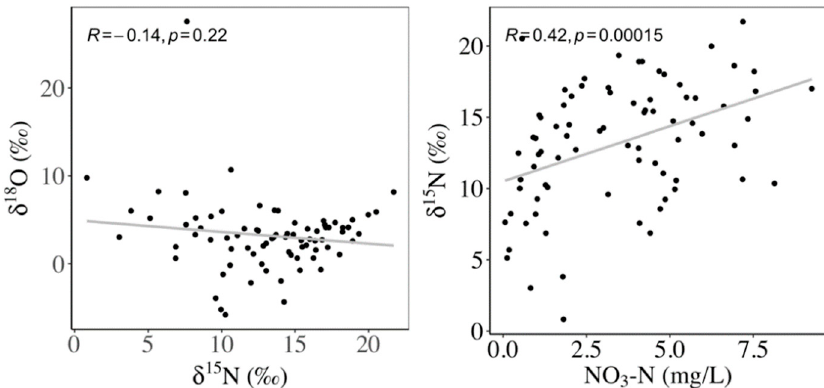
Figure 7. δ 15 N-NO 3 versus δ 18 O-NO 3 and NO 3 − -N in the Yuntaishan River. In the Yuntaishan River basin, the manure and sewage was the dominant source of NO 3 − -N (67%), which was higher than in other agricultural rivers in the Taihu Lake Basin (20%) and the Xijiang River (16%) in China [27,29]. Guan et al. [56] found that the rural